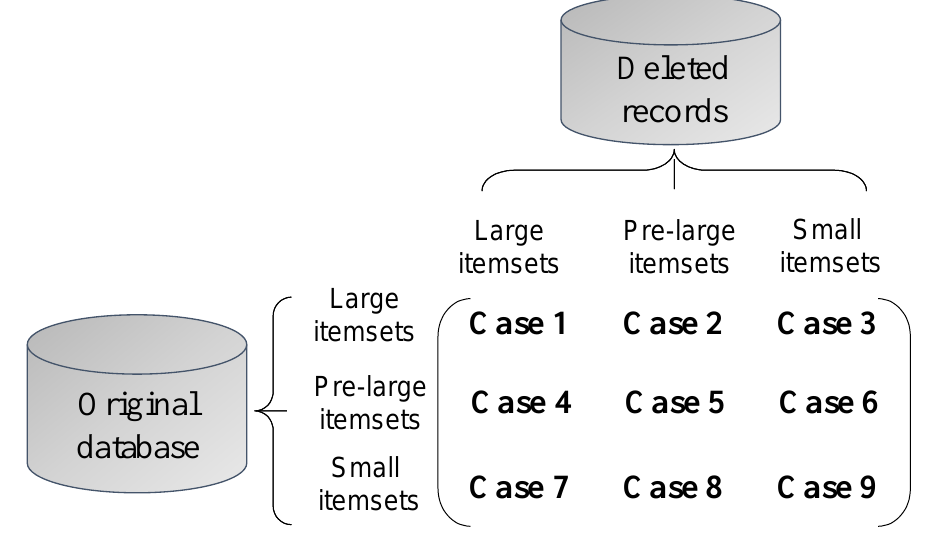
Figure 1. Pre-large concept for transaction